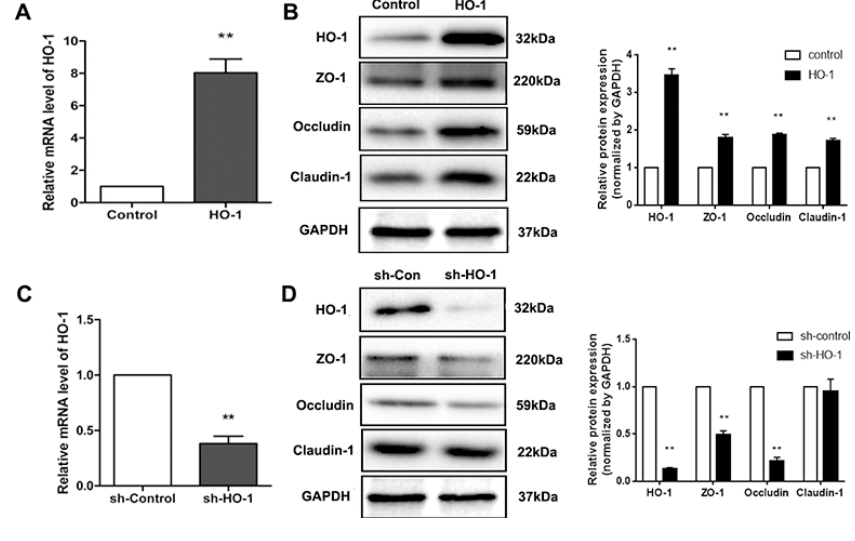
Figure 4. HO-1 and TJ protein expression in stable Caco-2 cells. (A) q-PCR results confirmed that HO-1 was overexpressed; (B) Western blot results verified that HO-1 protein was up-regulated in HO-1-transfected Caco-2 cells; meanwhile, ZO-1, occludin and claudin-1 expression levels were increased compared with the control. (C, D) q-PCR and Western blot results from the sh-HO-1 group. HO-1 expression was significantly de- creased in the sh-HO-1 group; ZO-1 and occludin were down-regulated as well. Data are presented as the mean ± SD from three independent experiments. ** P < 0.01 compared with the corresponding